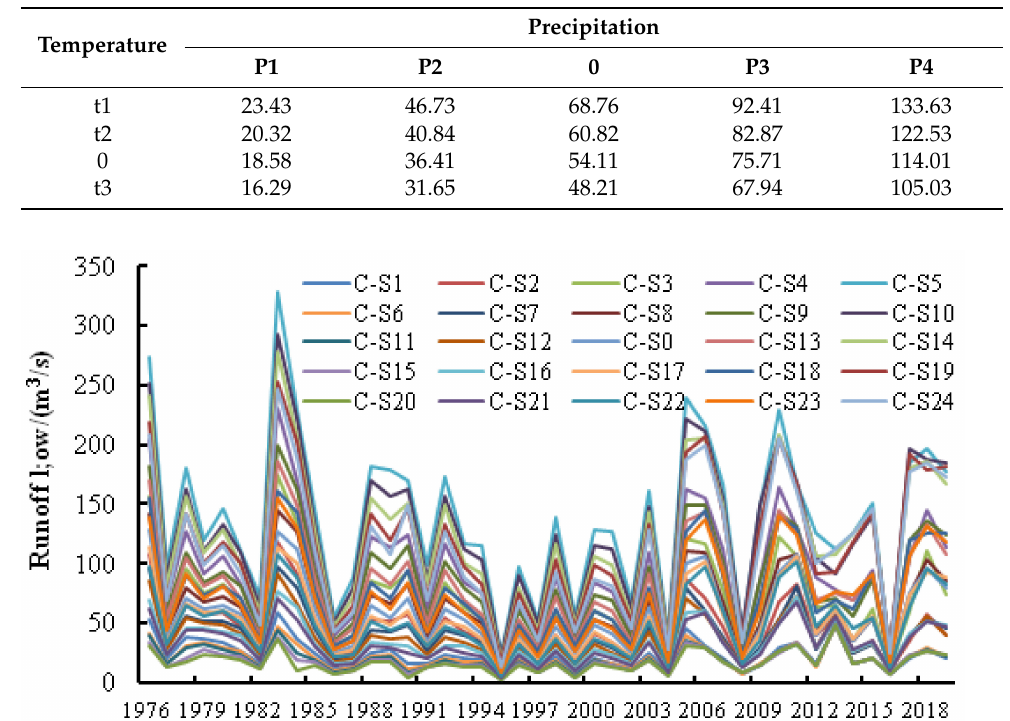
Table 6. Annual average simulated runoff of under different climate scenarios (m 3 · s − 1 ).